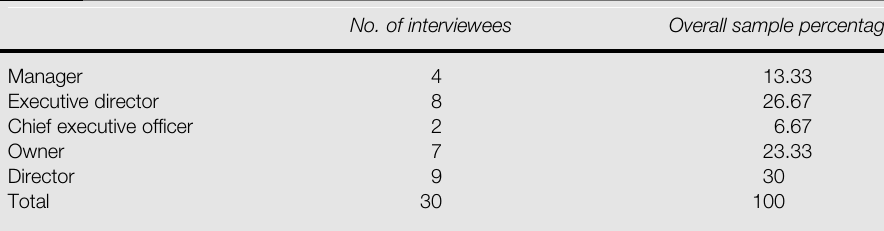
Table I Distribution of interviewees by